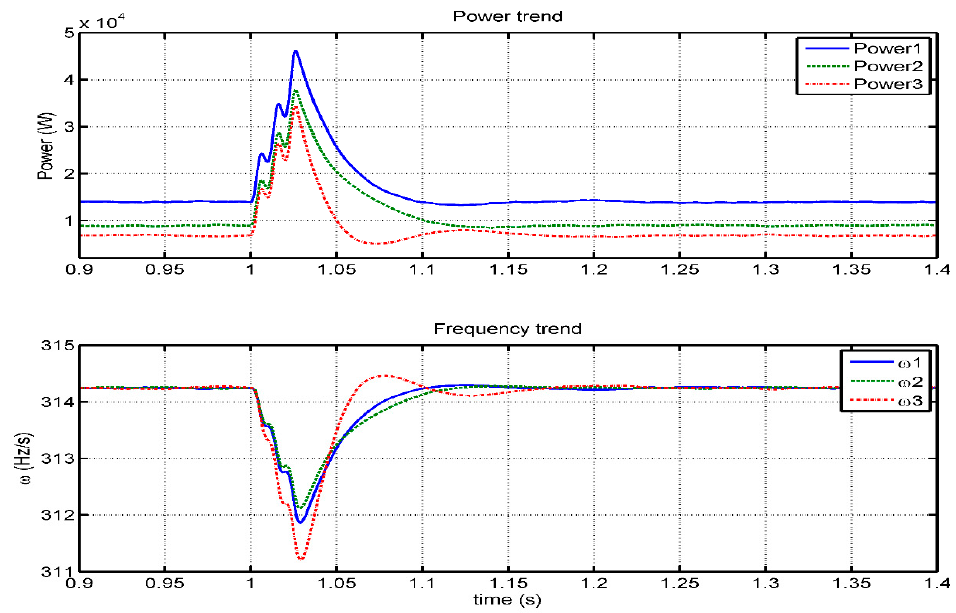
Figure 20. Fault Analysis Case II.